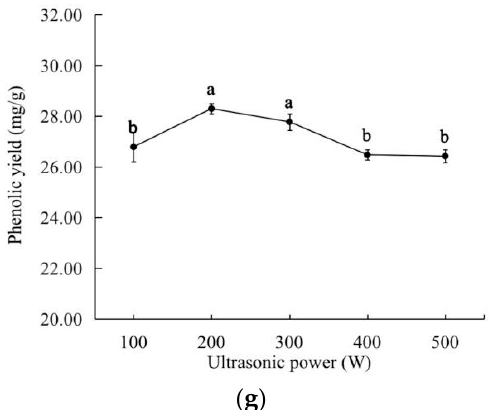
Figure 1. Effects of the different variables on the extraction yield of the total phenolics: ( a ) surfactant type; ( b ) SDS concentration; ( c ) ethanol concentration; ( d ) material-to-liquid ratio; ( e ) ultrasonic temperature; ( f ) ultrasonic time; ( g ) ultrasonic power. Different letters indicate significant differences ( p < 0.05)